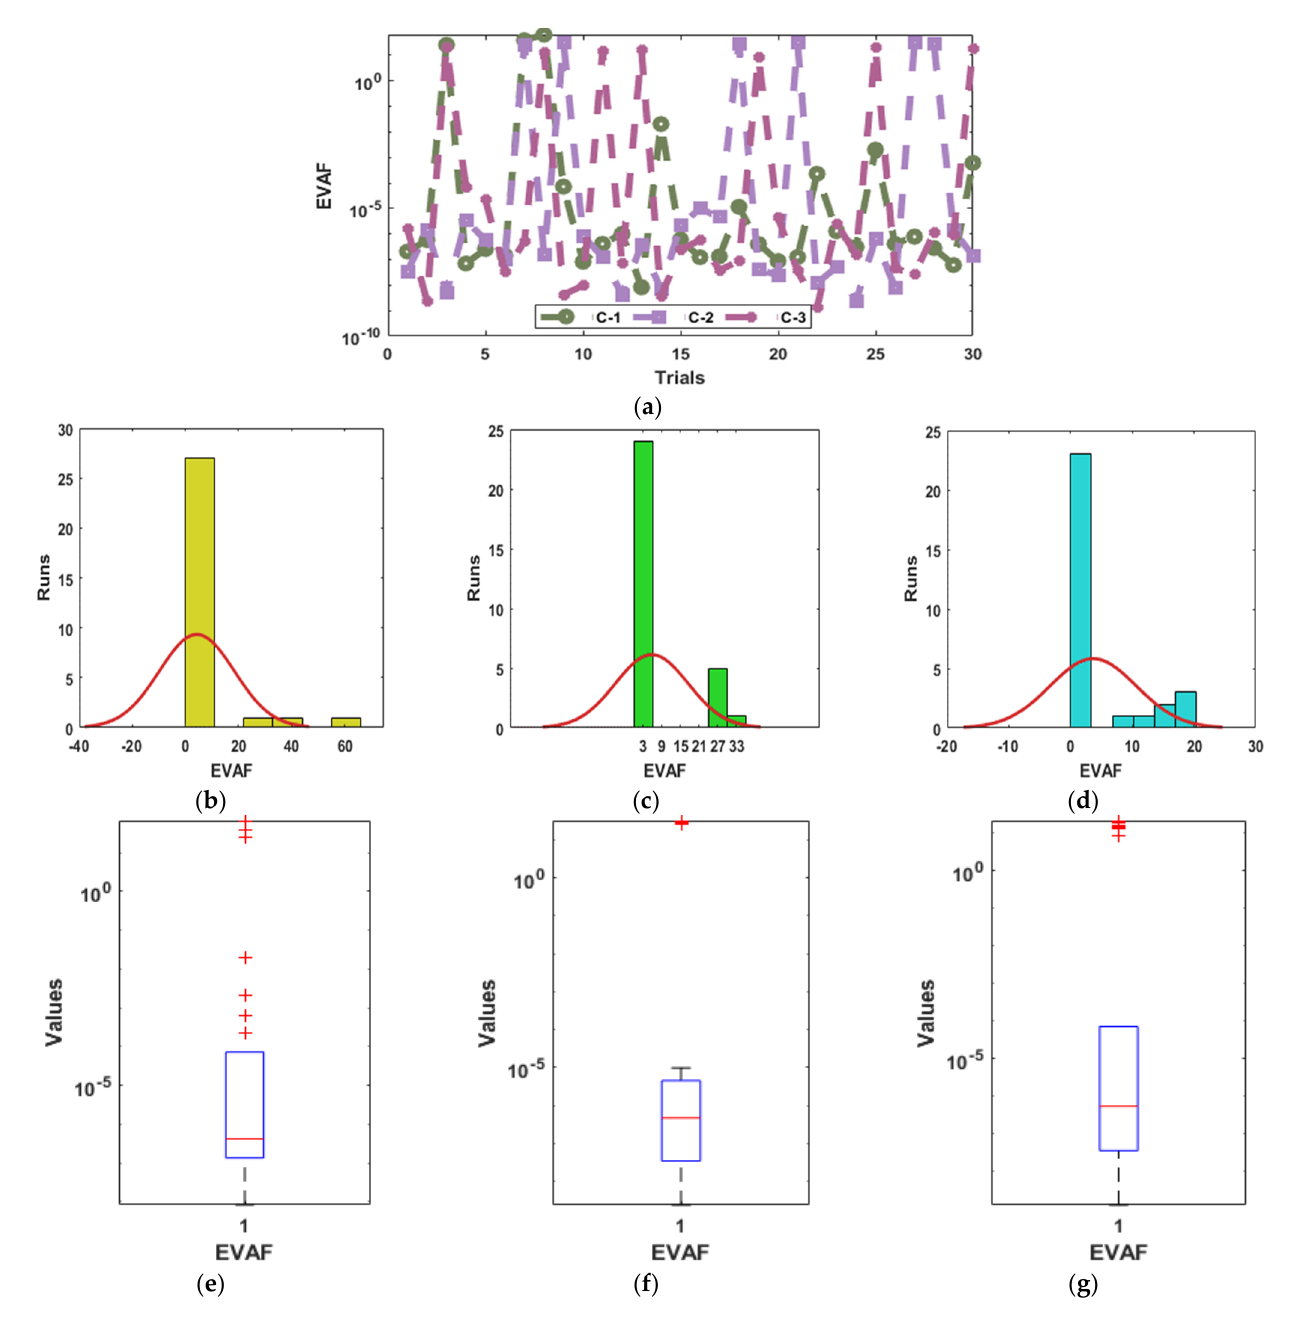
Figure 5. Performances through the statistical measures for the EVAF values based on the NSPM-SK. ( a ) Performances of the EVAF for case 1 to 3. ( b ) Hist of C-1. ( c ) Hist of C-2. ( d ) Hist of C-3. ( e ) BPs of C-1. ( f ) BPs of C-2. ( g ) BPs of C-3.